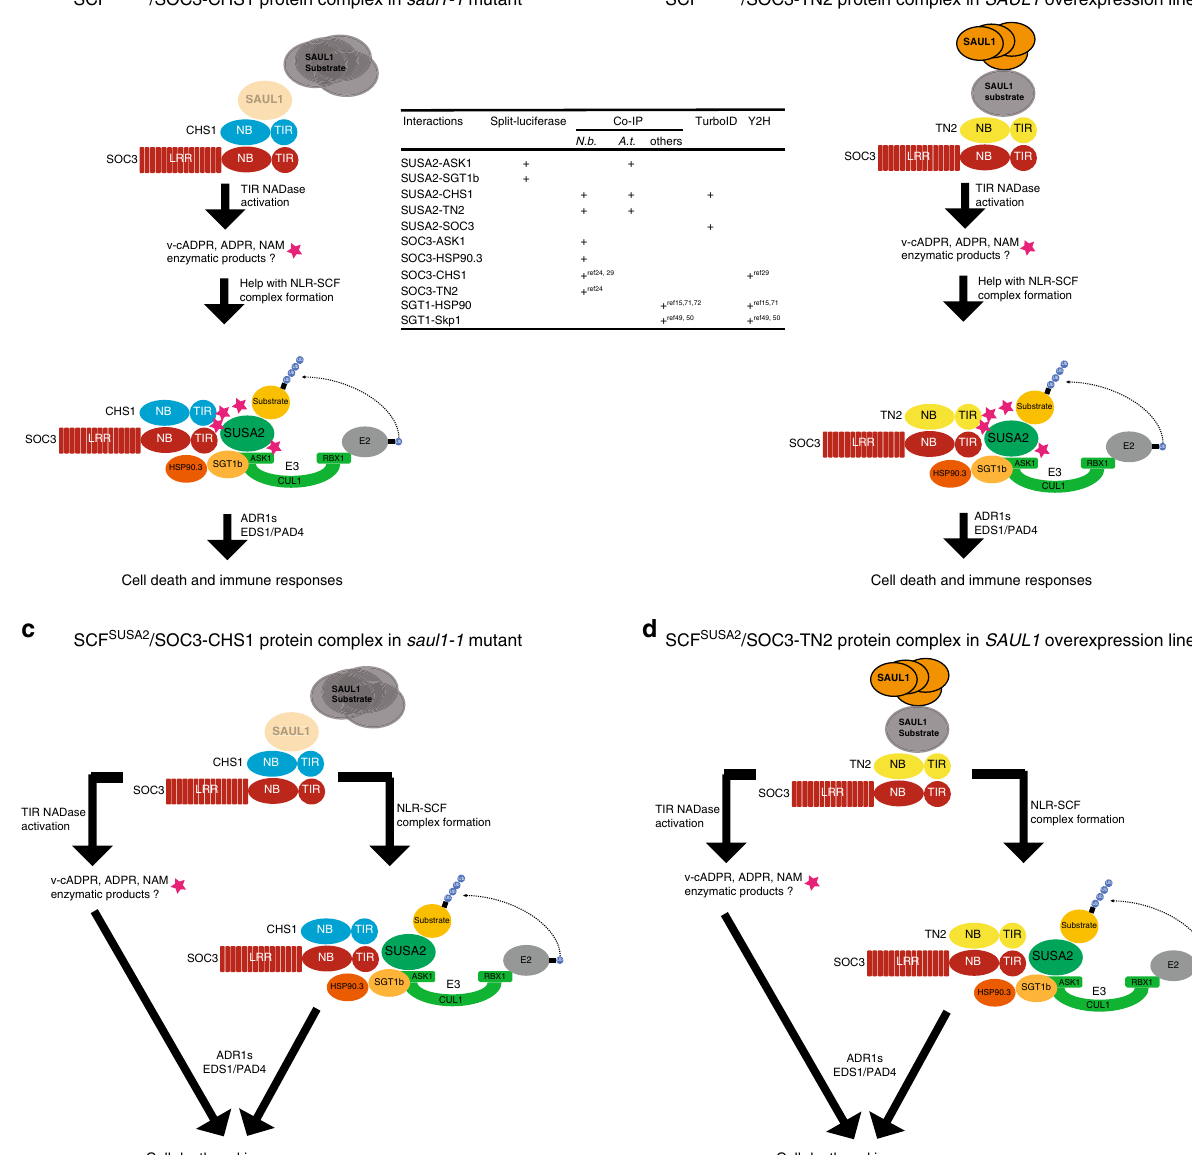
Fig. 7 The hypothetical assembly of the SOC3 – CHS1 or SOC3-TN2 NLR protein complex with SCF SUSA2 . This working model illustrates the assembly of the SCF SUSA2 E3 ligase complex with the SOC3 – CHS1 or SOC3-TN2 NLR pairs in saul1-1 mutant ( a , c ) or SAUL1 overexpression line ( b , d ), respectively. The middle table summarizes all the pairwise protein – protein interaction data supporting such a model. “ + ” represents positive protein – protein interactions. Blank space means not tested. The references are indicated as shown in the fi gure 15,24,29,49,50,71,72 . Here, NLR pairs SOC3 – CHS1 and SOC3-TN2 guard the homeostasis of E3 ligase SAUL1, where SOC3 – CHS1 is activated upon SAUL1 disappearance, while SOC3-TN2 is triggered upon SAUL1 overexpression 24,25 . Activation of such NLR – SCF protein complex leads to the ubiquitination and degradation of the substrate of the SCF SUSA2 E3 ligase, which is currently unknown. SOC3 – CHS1 or SOC3-TN2 pairs may not necessarily exist as dimers; they more likely form oligomers as in the case of ZAR1 resistosome. During NLR activation, TIR domain dimerization or oligomerization of either SOC3-CHS1 or SOC3-TN2 in saul1-1 or 35S::SAUL1 plants turn on TIR NADase activity, leading to accumulating of its products 57,58 . Under a linear model ( a , b ), one of the TIR products may act as a glue (star in the fi gure) to help with NLR – SCF complex formation, similar to the binding of auxin to the SCF TIR1 receptor complex to promote auxin responses ( a , b ) 59 . However, a branching model is equally possible ( c , d ), where the induction of cell death by TIR NADase products is through an unknown molecular mechanism, which is independent of the E3 ligase activity in NLR – SCF complex. The assembly of the SCF SUSA2 – NLR complex triggers downstream defense activation, which is relying on EDS1, PAD4, and helper NLRs ADR1s 28,30,70 . Canada). 2 µg RNA was reversely transcribed to cDNA using Easy Script TM reverse DNA extraction kit. The library preparation and Illumina sequencing were performed by BGI (Beijing Genomic Institute, Beijing, China). transcriptase (ABM, Canada). 50 ng cDNA was added as a template in a 10µl reaction on a Bio-Rad CFX Connect TM Real-Time system machine. Real-time PCR was conducted to quantify the relative expression level of the target genes. ACTIN1/ Gene expression analysis . Total RNA was extracted from 50 mg plant tissue, 7 was used to normalize the expression value. either 12-day-old 1/2 MS medium-grown seedlings or 4-week-old soil-grown plants using the EZ-10 Spin Column Plant RNA Mini-Preps Kit (Bio Basic, NATURE COMMUNICATIONS| (2020) 11:5190